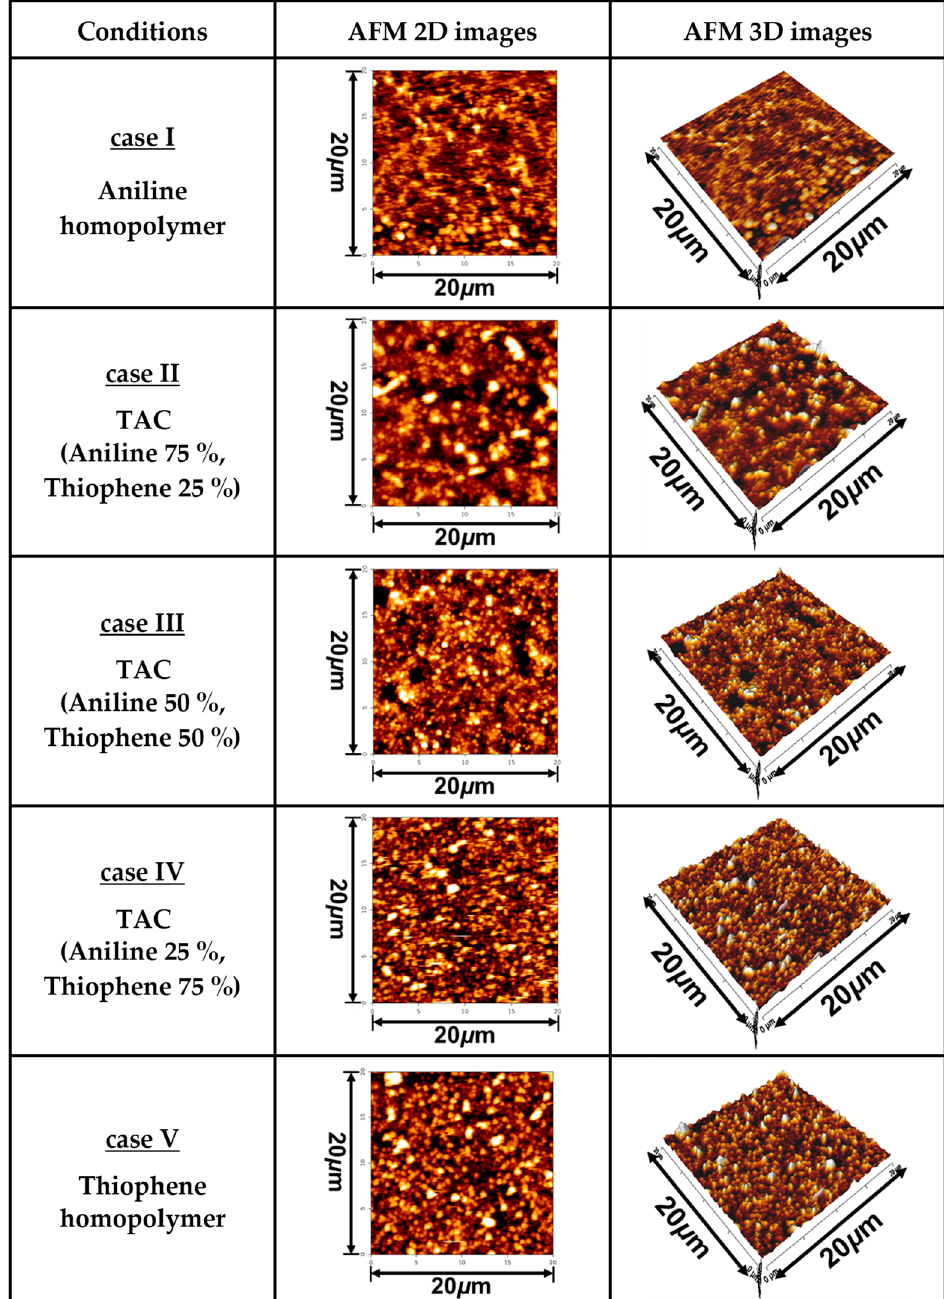
Figure 4. Two- (2D) and three-dimensional (3D) AFM images of TAC film surfaces grown on glass substrate by APPJs technique relative to various ratios of blended solutions of aniline and thiophene monomers.